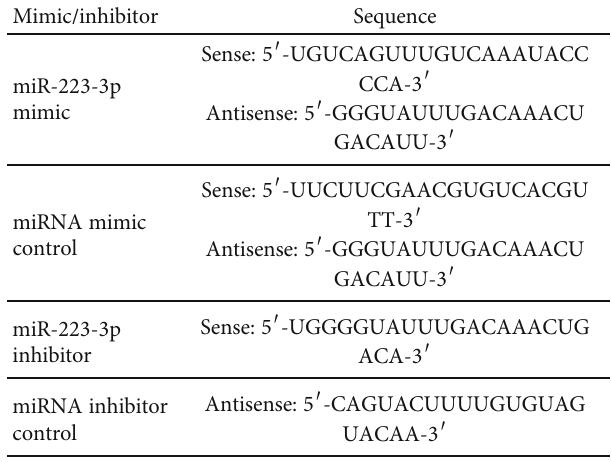
Table 1: Sequences of the miR-223-3p mimic/inhibitor and